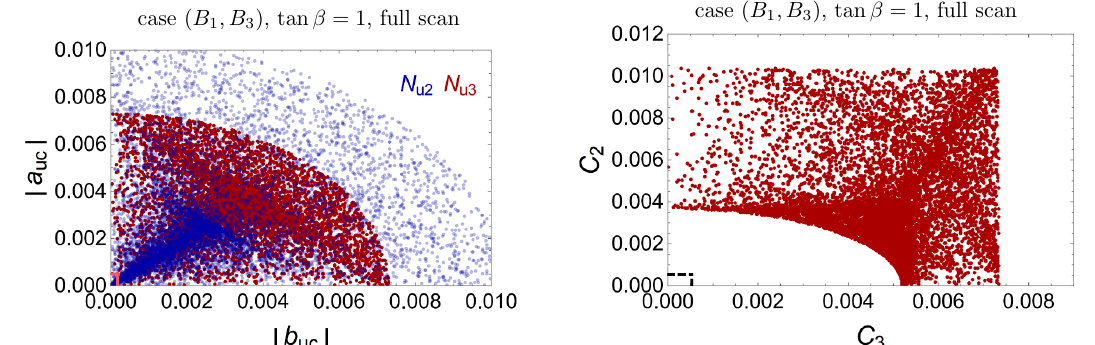
Figure 7 . Left: the values of | a uc | vs. | b uc | from N u 2 and N u 3 in a full scan of case ( B 1 , B 3 ) . Right: the interplay between N in eq.